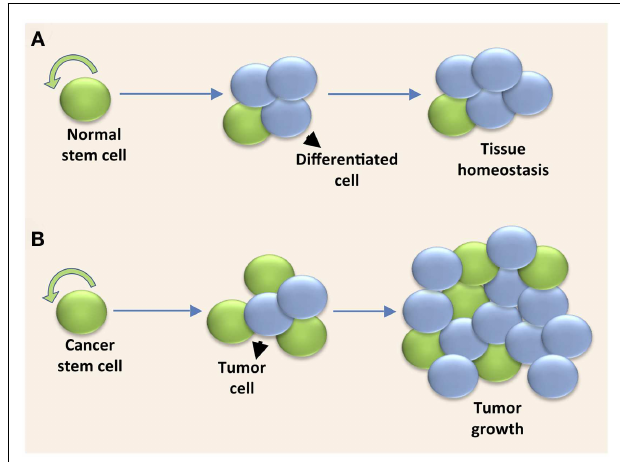
FIGURE 1 | Solid tumors are fueled by cancer stem cells undergoing excessive symmetric cell divisions . (A) A normal stem cell maintains tissue homeostasis by self-renewing and providing the differentiated cell types within the tissue through a controlled series of symmetric and asymmetric cell divisions. (B) A cancer stem cell fuels uncontrolled tumor growth when it undergoes excessive symmetric cell divisions due to dysregulated